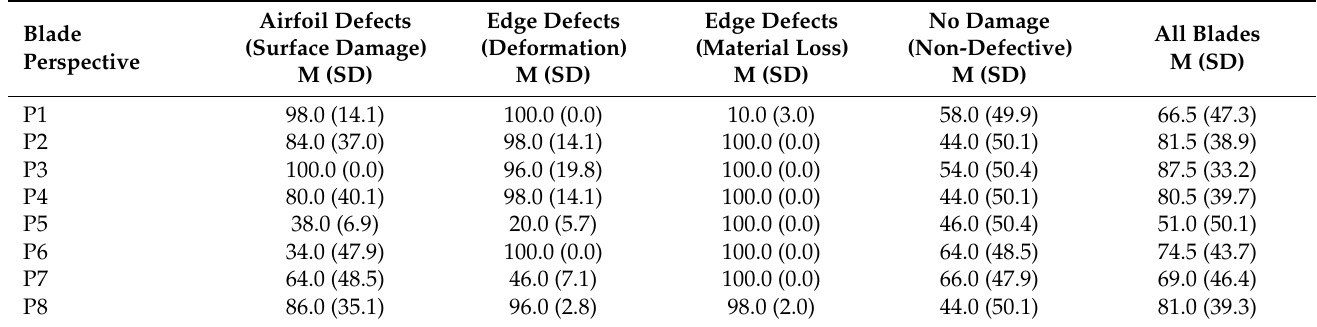
Table 5. Inspection accuracies by blade perspective and defect group (in